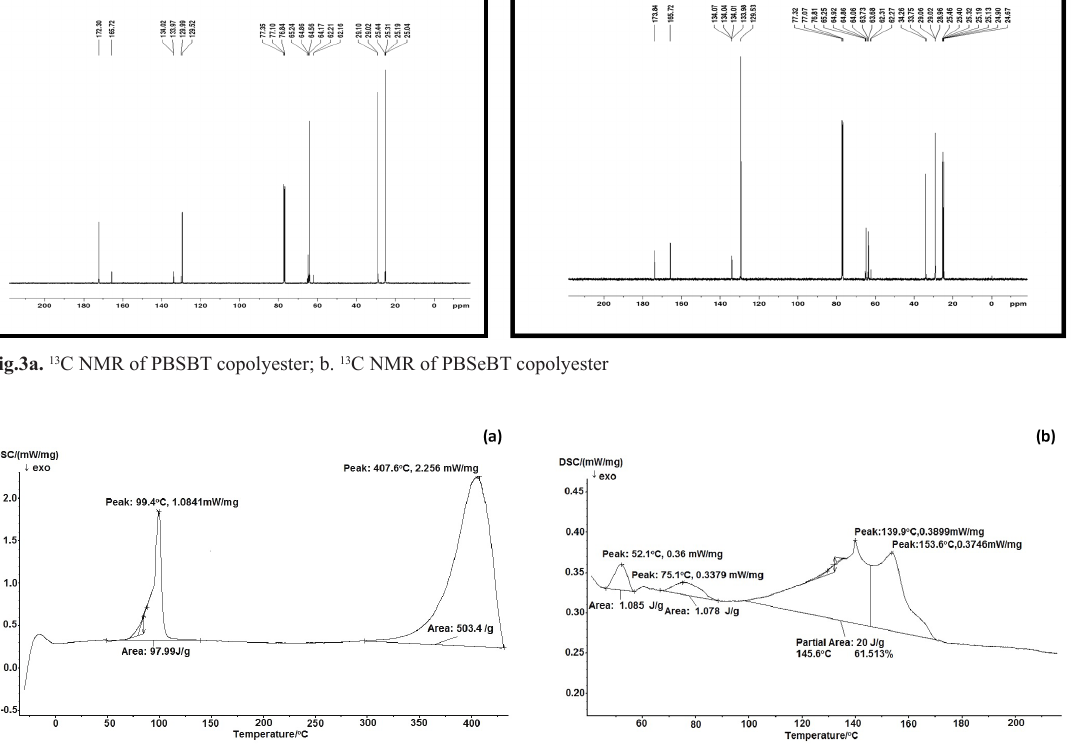
Fig.4a. DSC Thermogram of PBSBT copolyester; b. DSC Thermogram of PBSeBT